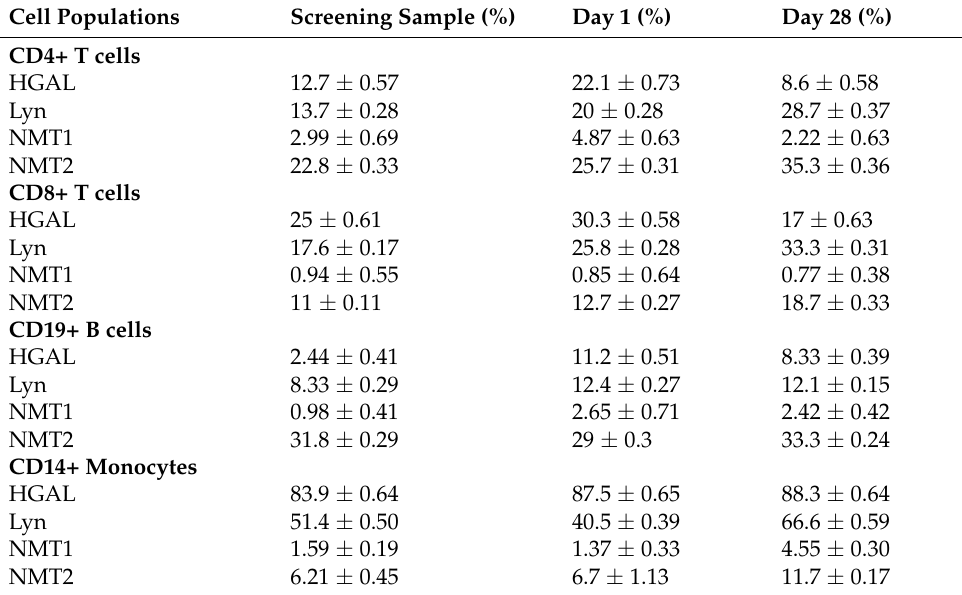
Table 3. Impact of PCLX-001 treatment on the intracellular level of HGAL, Lyn, NMT1, and NMT2 in CD4+ T cells, CD8+ T cells, CD19+ B cells, and CD14+ monocytes. Cell Populations Screening Sample (%) Day 1 (%) Day 28 (%) CD4+ T cells